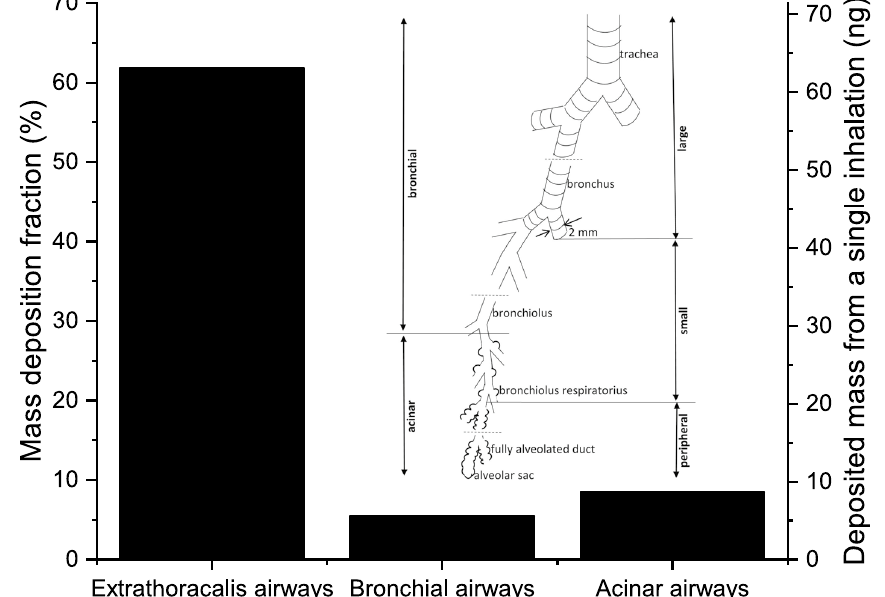
Figure 2. Mass deposition fraction of inhaled particles (left axis) and deposited mass from a single inhalation (right axis) in the extrathoracic, bronchial and acinar regions of the lungs upon exposure to cough-generated droplets and aerosol particles. The insert shows the subdivisions of the intrathoracic airways.